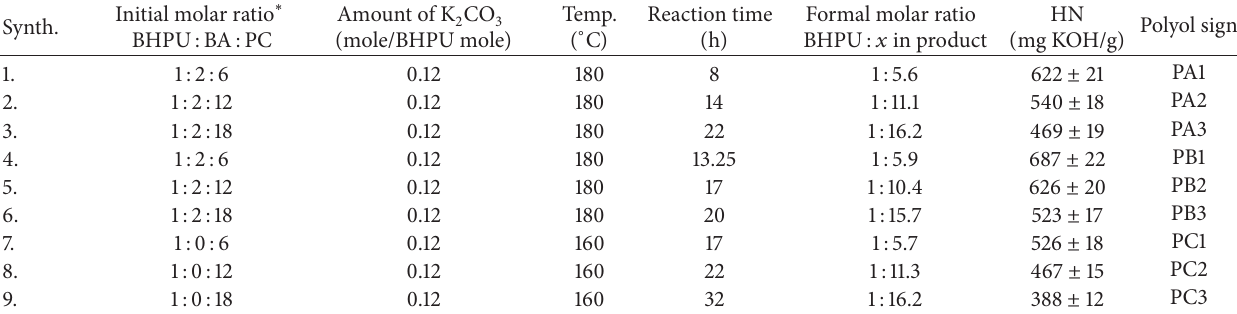
Table 1: Polyol synthesis conditions and